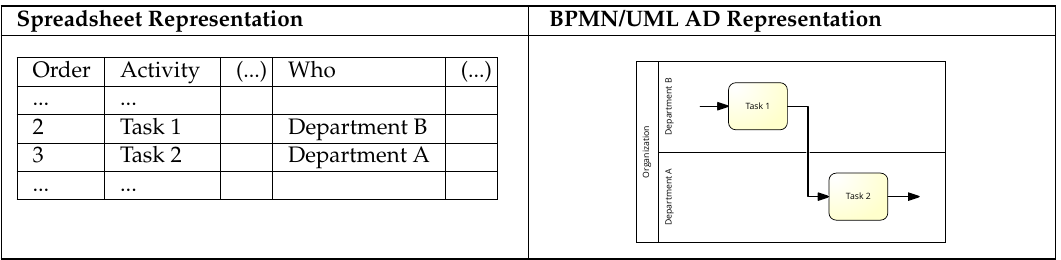
Table 14. Swimlanes example.